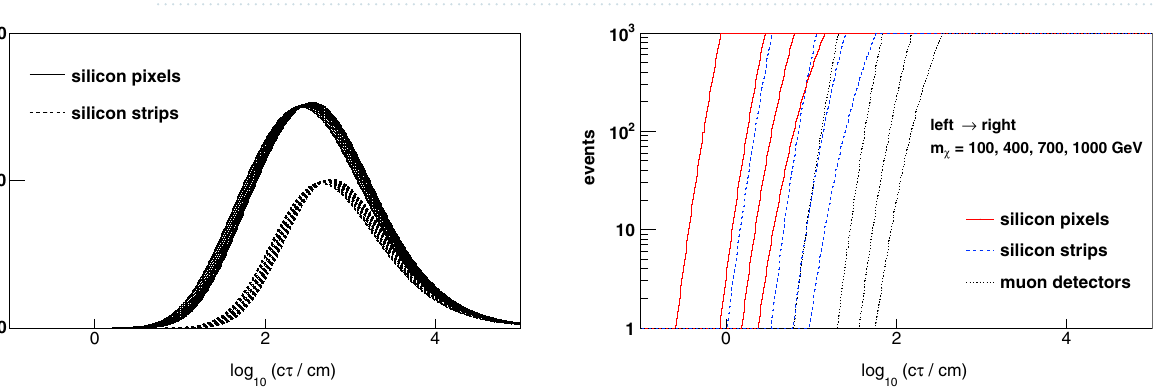
Figure 2. (Left) The distribution of transverse momentum p T of charged particles χ ± pair-produced at the LHC via the Drell-Yan process, calculated using the pythia 8.219 event generator 50 and the nnpdf3.1 set of parton distribution functions 51 . The approximate scaling property of this distribution is shown by plotting p T / m χ , where m χ is the particle mass. (right) The corresponding distributions of the quantity βγ sin θ , which takes into account both the Lorentz-boost and the path-length factors relevant for the trigger efficiency with cylindrical detectors. The distributions vary little over the wide range 100 < m χ < 900 GeV. The typical boost for lighter particles is slightly larger that the boost for heavier particles.